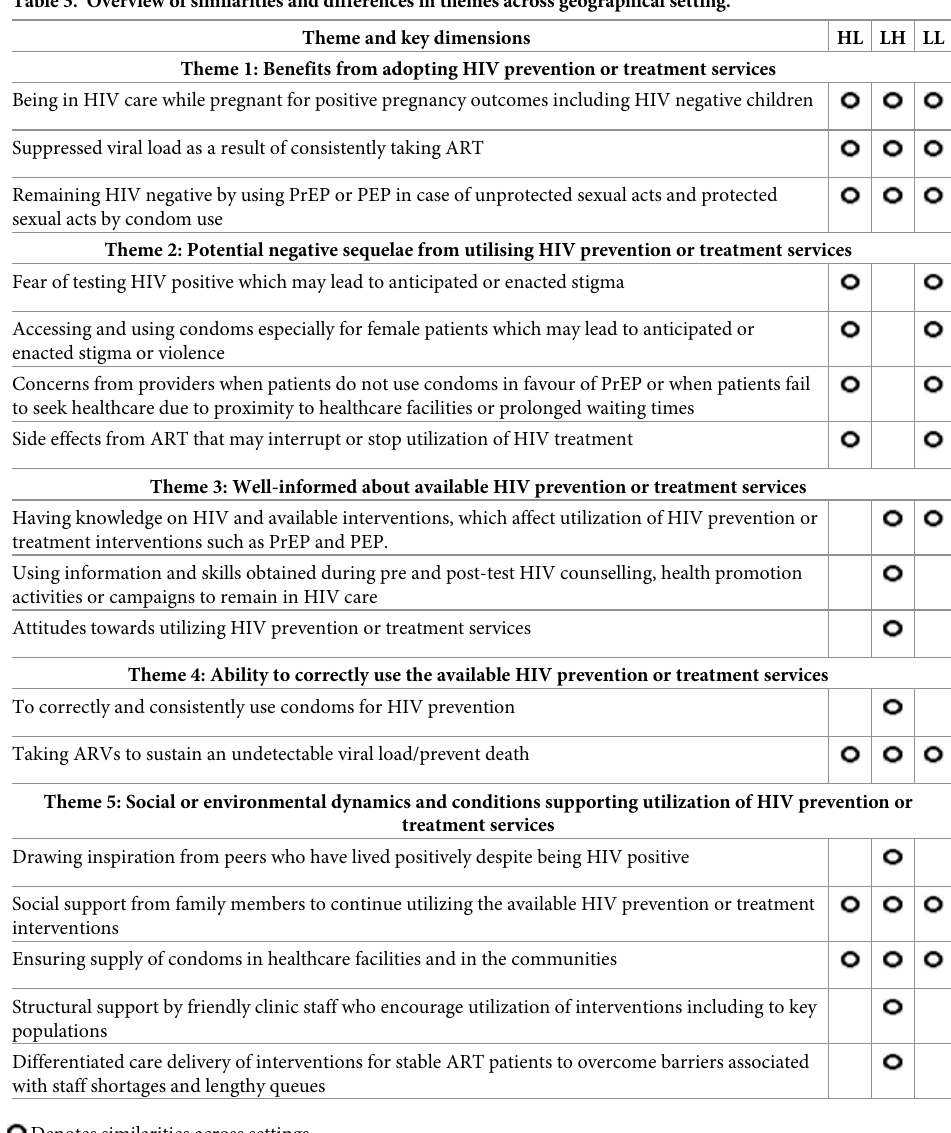
Table 3. Overview of similarities and differences in themes across geographical